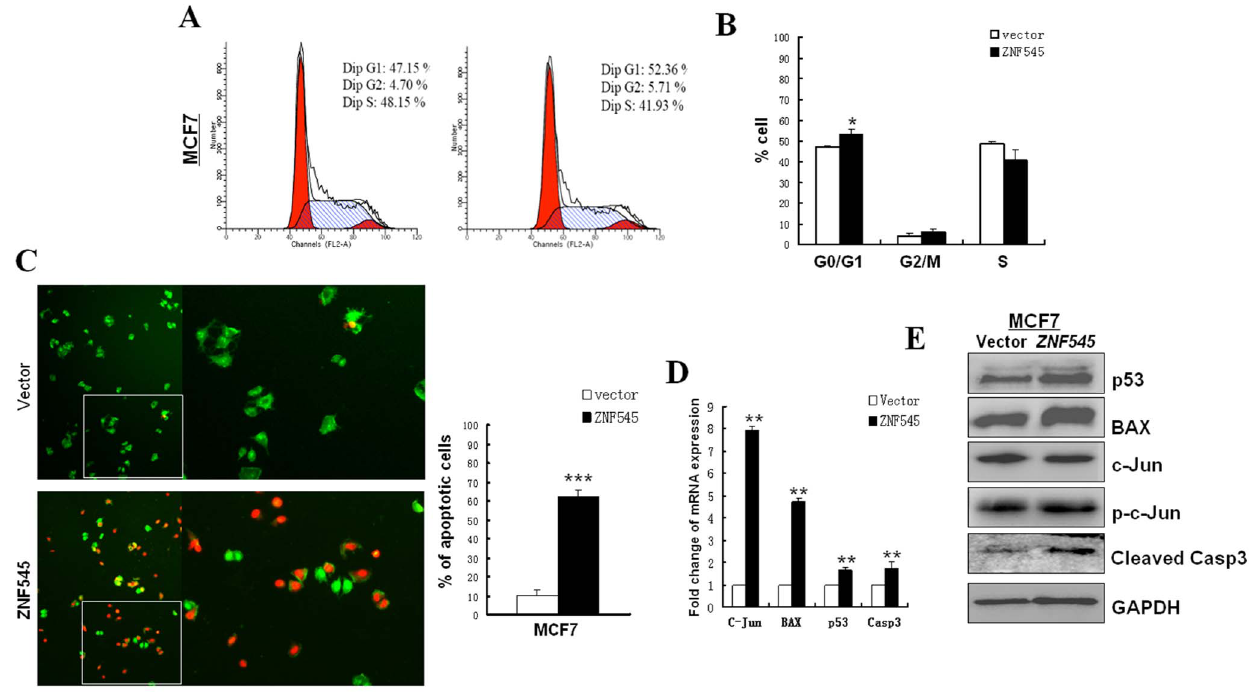
Figure 4. Ectopic expression of ZNF545 induced apoptosis and cell cycle arrest in MCF7 cells. (A) Anlysis of cell cycle distribution of vector-, ZNF545-transfected MCF7 cells. The distribution and percentage of cells in G1, S and G2/M phase of the cell cycle are indicated. B) Representative flow cytometry histograms of cell cycle alterations. The assay was performed in triplicate (*, P , 0.05).(C), Apoptosis was examined using Acridine orange/ethidium bromide (AO/EB) fluorescence staining. The percentage of apoptotic cells is indicated(***, P , 0.001). (D). Expression levels of C-Jun, BAX, p53 and Casp3 were evaluated by real-time PCR in vector-, ZNF545-transfected MCF7 cells. (E). Expression levels of C-Jun, BAX, p53 and Casp3 were evaluated by westernblot in vector-, ZNF545-transfected MCF7